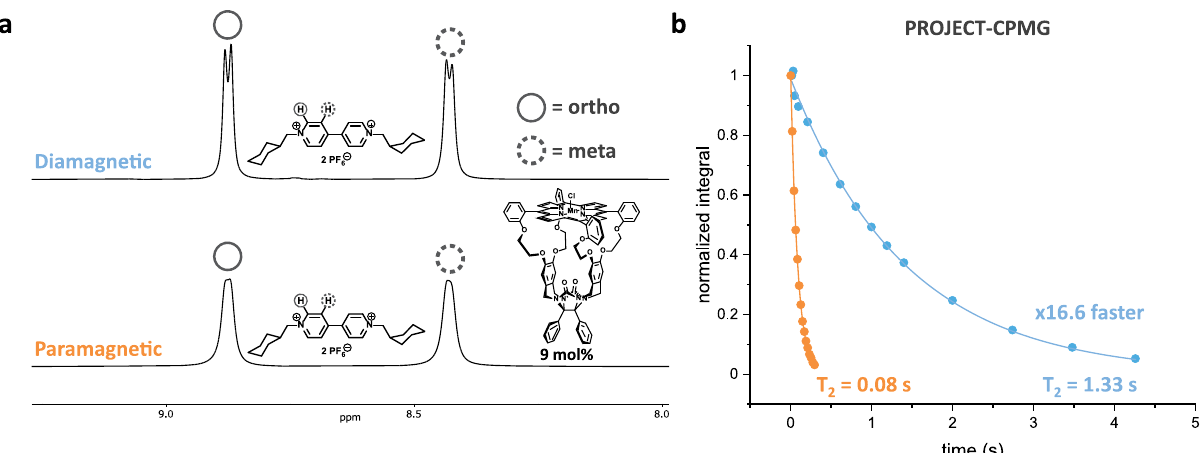
Fig. 3 In fl uence of the presence of Mn1 on T 2 values of free guest proton signals. a Top: 1 H NMR spectrum of V1 (500 MHz, chloroform- d : acetonitrile- d 1 H NMR spectrum of V1 in the presence of 9 mol% Mn1 (500 MHz, chloroform- d : acetonitrile- d 3 , 1:1 (v/v), 20 °C), bottom: exponential fi rst order plots of PROJECT-CPMG measurements and the determined T 2 values for the relaxation of the unbound meta-protons of V1 and of V1 in the presence of 9 mol% Mn1 (20 °C), showing an enhancement factor of 16.6×. The color-coding blue and orange refer to the experiments without (diamagnetic) and with (paramagnetic) Mn1 present,